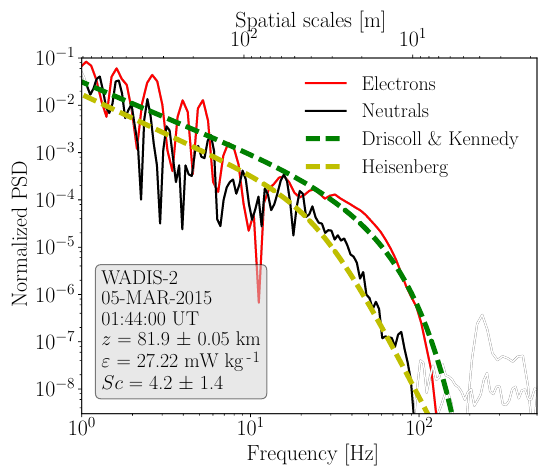
Figure 11. Global wavelet spectrum from 81.85 to 81.95km of elec- tron density fluctuations (solid black line) and of neutral density fluctuations (solid red line). The dashed lines shows the best fit of the theoretical models of Driscoll and Kennedy (1985) (green) and of Heisenberg (1948) (yellow). ε was kept constant for the fit of the Driscoll and Kennedy model to the electron density fluctuations and is obtained from the fit of the Heisenberg model to the neutral den- sity fluctuations. The Driscoll and Kennedy fit yielded a Schmidt number of Sc = 4 . 2 ± 1 . 4.